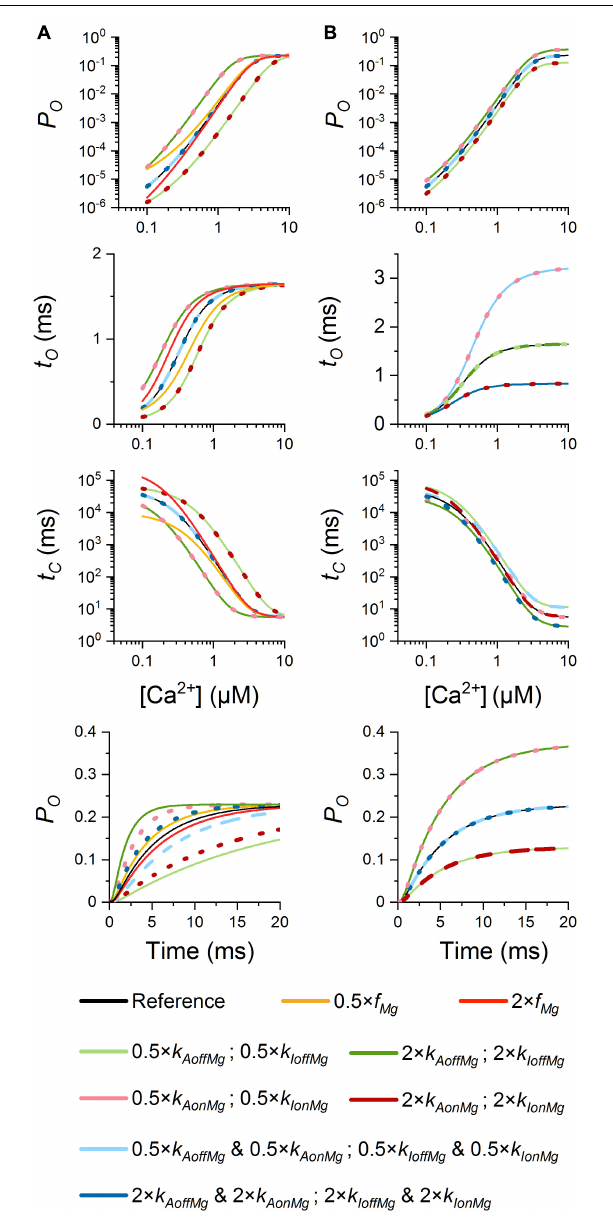
FIGURE 5 | Simulated dependence of RyR single-channel characteristics on Mg 2 + binding. P O ([Ca 2 + ]), t O ([Ca 2 + ]), t C ([Ca 2 + ]), and P O ( t ) were calculated with Eqs. 14, 2, 2, and 4, respectively. (A) Variation of Mg-binding to the RyR activation site. (B) Variation of Mg-binding to the RyR inhibitory site. Bottom panels: time courses of P O evolution after a stepwise increase of [Ca 2 + ] from 0.1 to 20 µ M. Color-coding is described in the legend. The conditions that had the same effect are shown in solid, dashed, or dotted lines. Note the logarithmic scale of P O and t C .